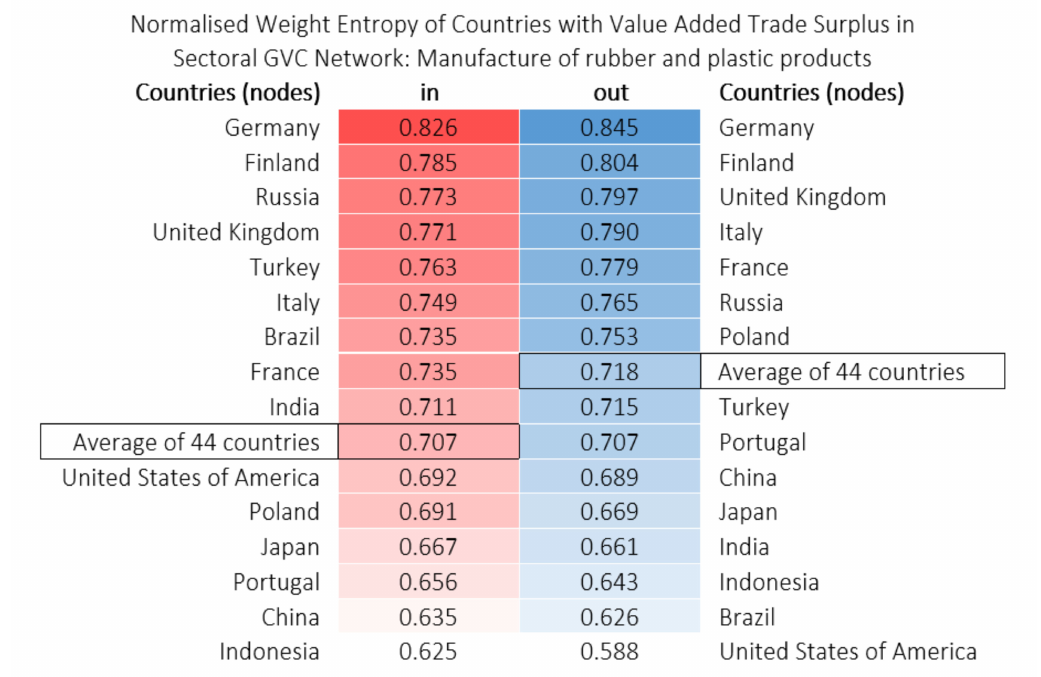
Figure 6. Sectoral GVC network: “Manufacture of rubber and plastic products”. Normalized in- and out-weight entropy average (2000–2014) of countries with a value added trade